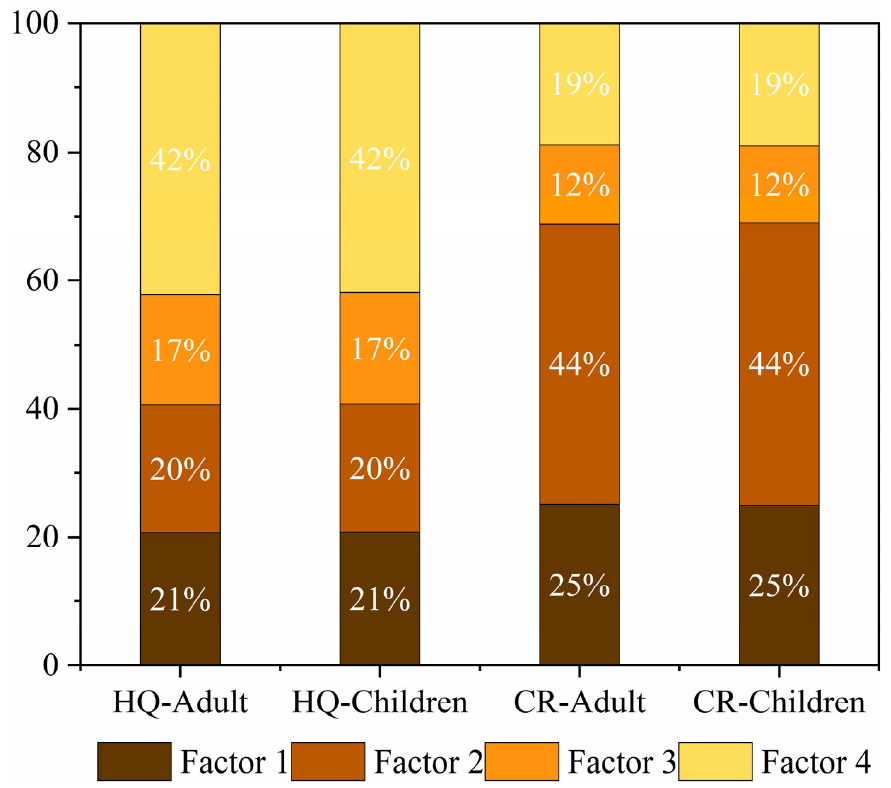
Figure 10. Contribution ratio of heavy metal sources to HI and CR values for adults and children.